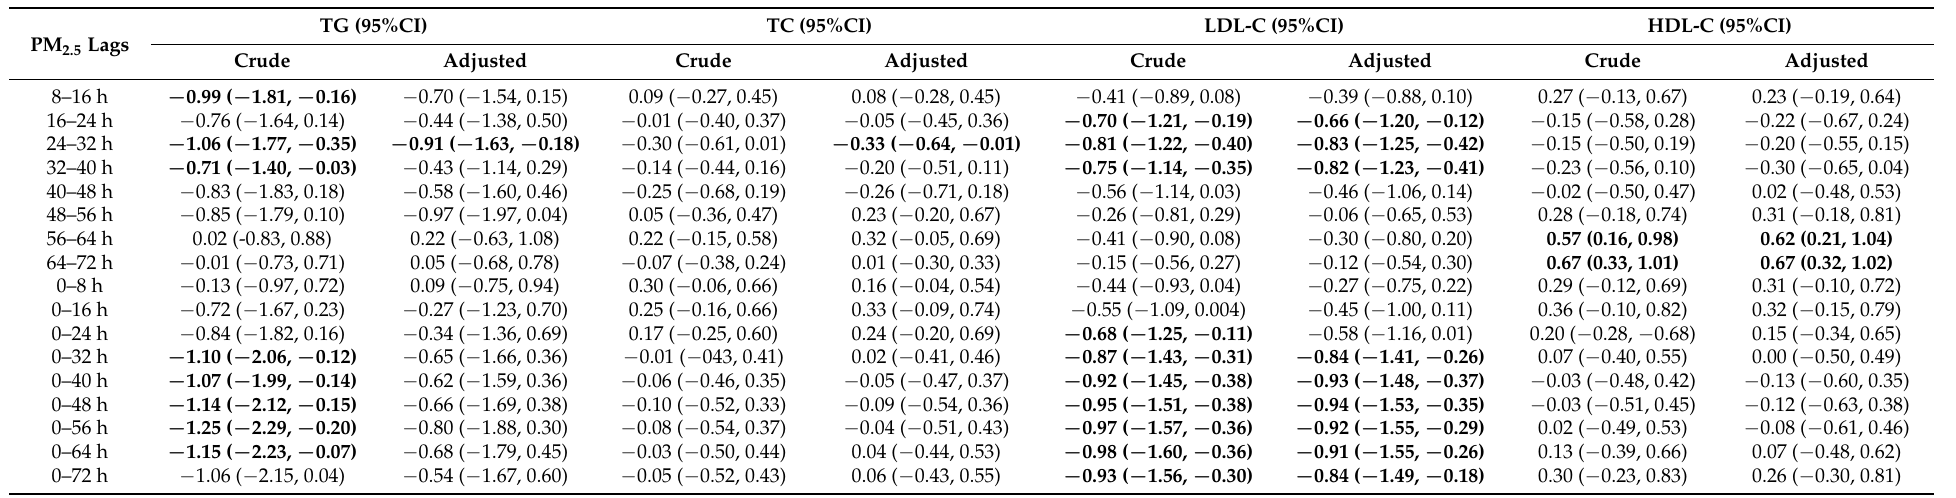
Table 2. Association between per 10 µ g/m 3 increment in PM 2.5 and blood lipid